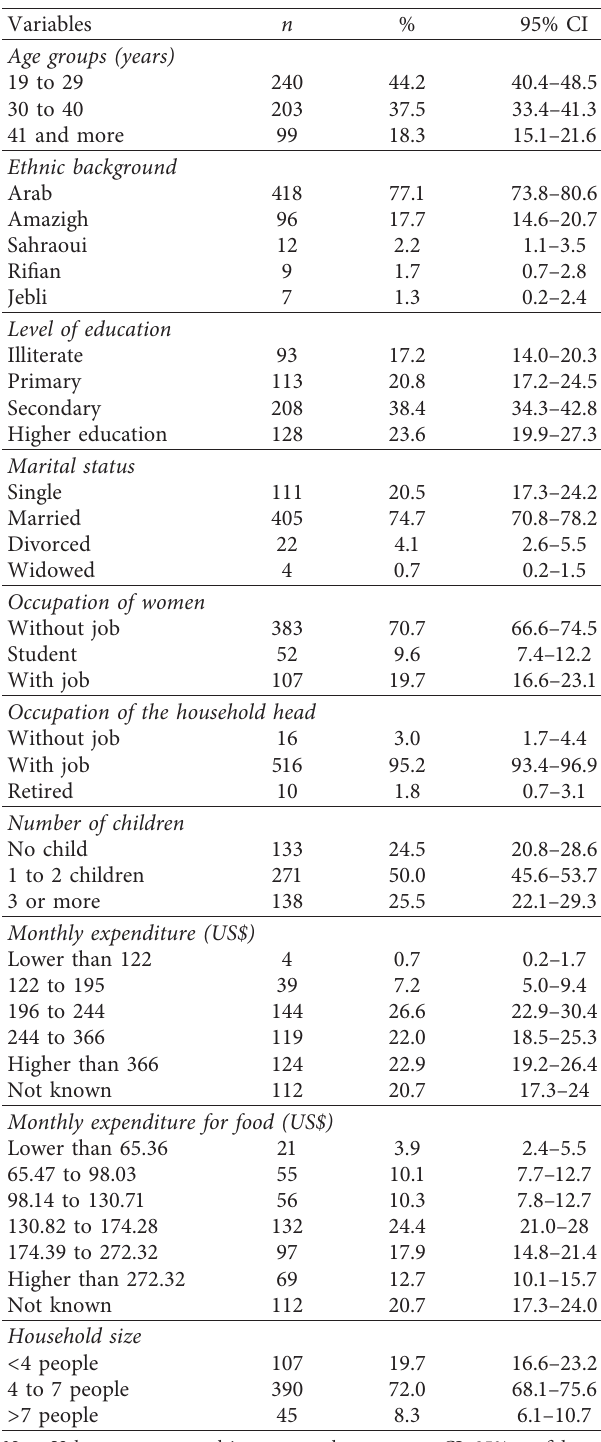
Table 1: Demographic and socioeconomic characteristics of the study